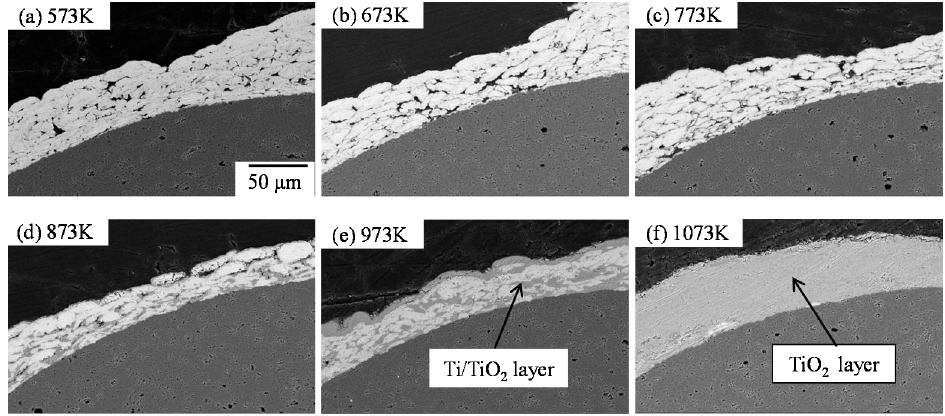
Figure 28. SEM images of cross sections of M10- x K-50h